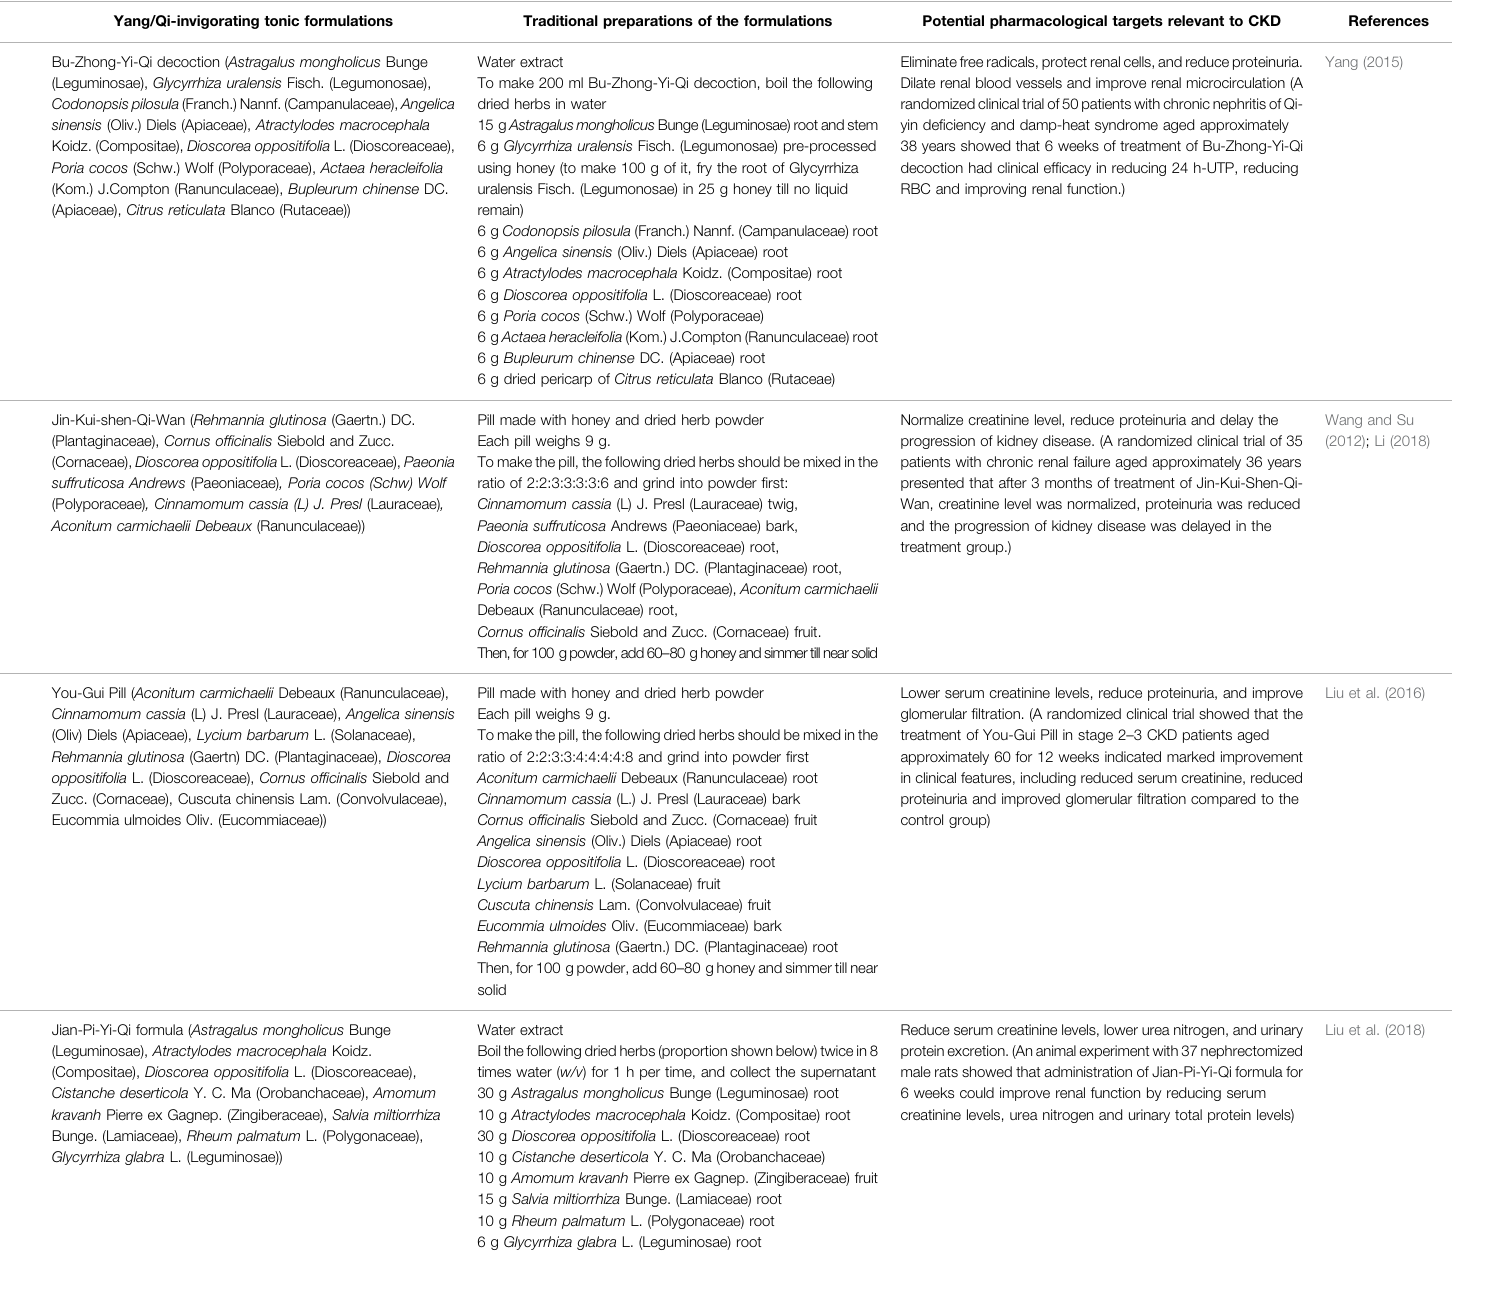
TABLE 1 | ( Continued ) Effects of Yang/Qi-invigorating formulations on the treatment of CKD. Cause of CKD Yang/Qi-invigorating tonic formulations Traditional preparations of the formulations Potential pharmacological targets relevant to CKD